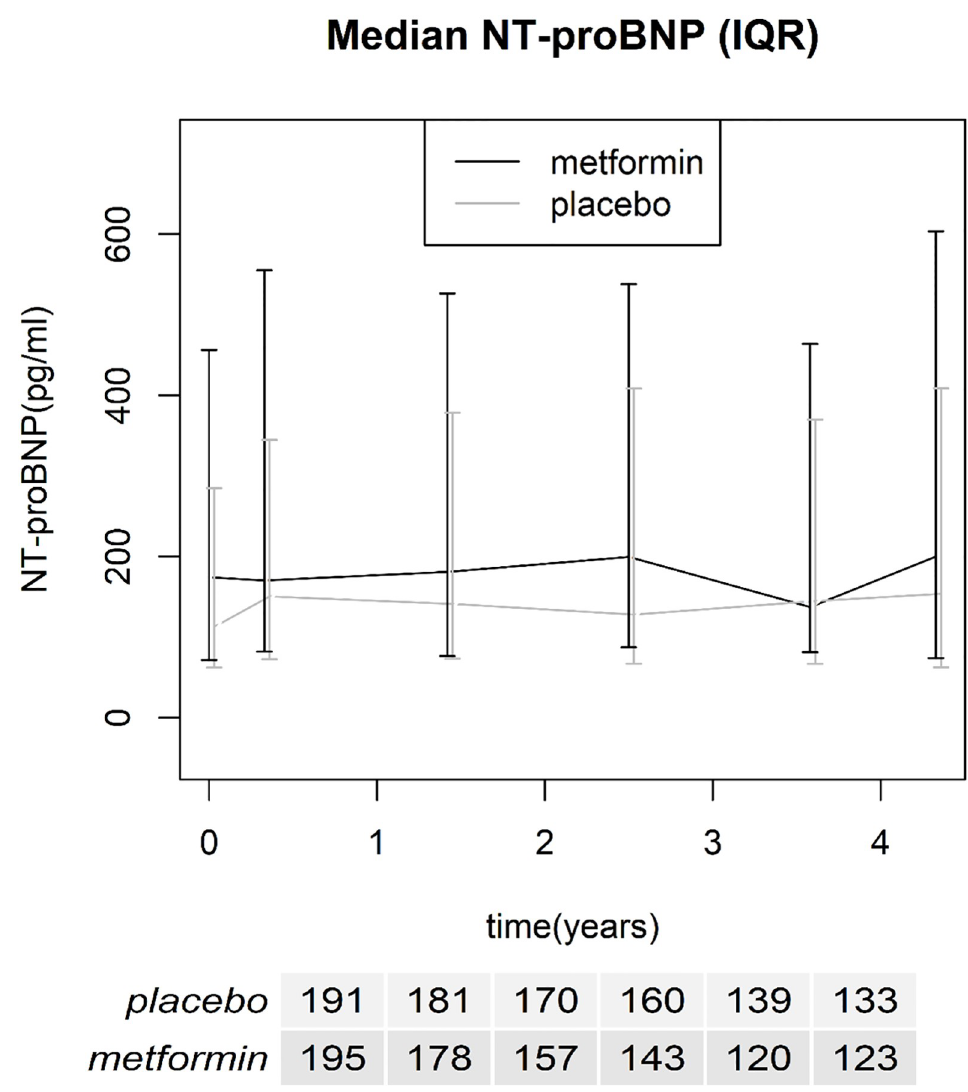
Fig 2. Median NT-proBNP over time with interquartile range, number of included patients for each time point is reported in the table below the x-axis.